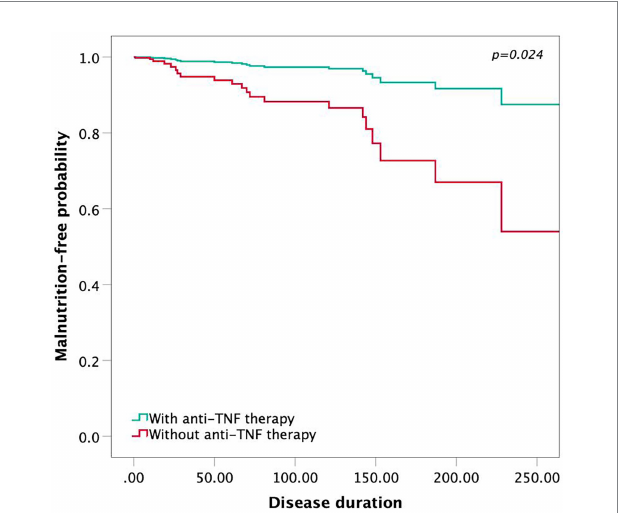
FIGURE 4 The Cox proportional hazards model showing the malnutrition-free probability by anti-TNF